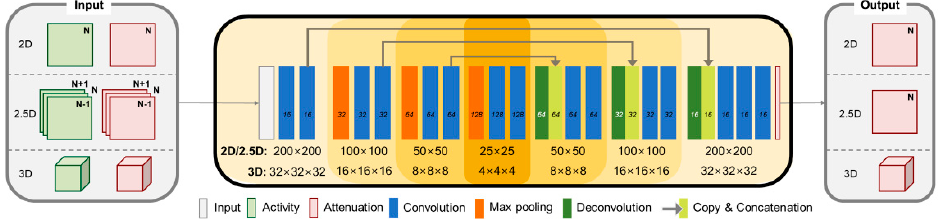
Figure 1. U-net architectures used to learn μ -CT from λ -MLAA and μ -MLAA, which were concate- nated and passed in two input channels. The first row in the right box shows the network architec- ture. The dimensions of the input/output images and feature maps were different depending on the dimension of the network models (2D, 2.5D, or 3D). The dimensions of the feature maps in each layer are shown in the second row in the right box.